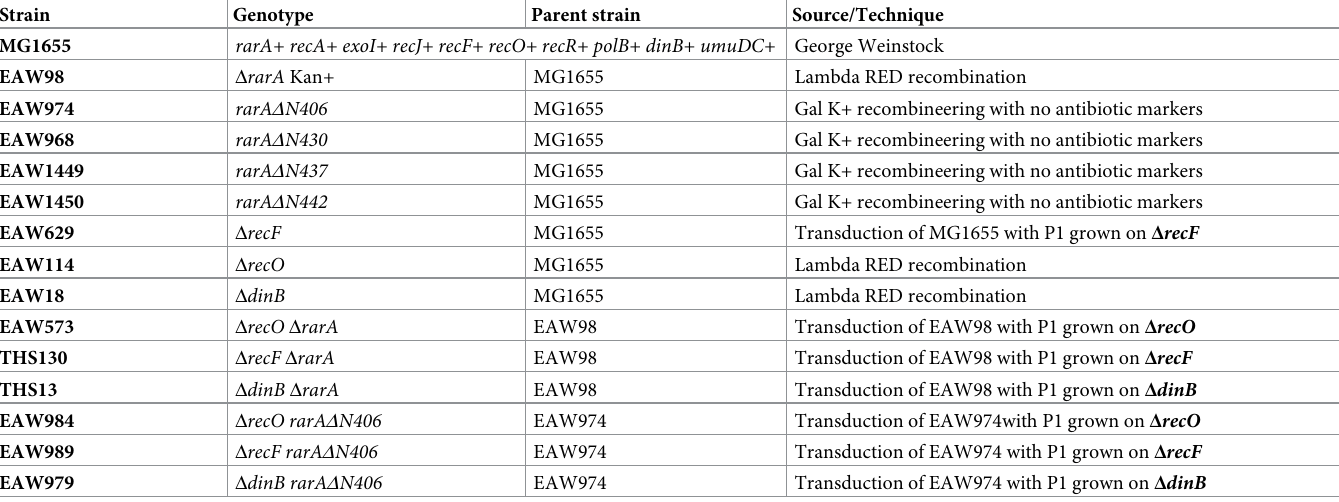
Table 1. List of strains used in this study. Strain Genotype Parent